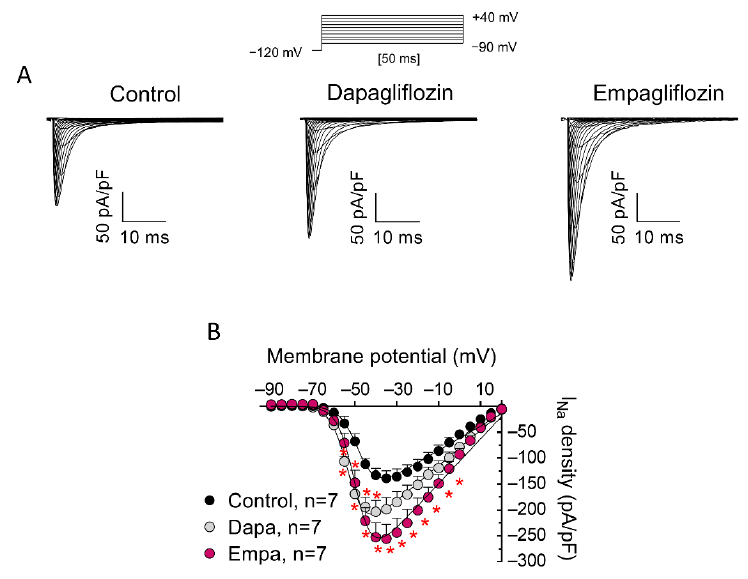
Figure 1. Incubation with dapa and empa increased I Na recorded in hiPSC-CMs. ( A ) I Na traces recorded, using the protocol shown at the top, in three different hiPSC-CMs: incubated with dapa or empa (1 µ M, 24-h) or not incubated (control). ( B ) Current density-voltage relationships for peak I Na recorded in hiPSC-CMs incubated with dapa or empa or not incubated. In B, each point is the mean ± SEM of the “n” experiments indicated in the figure. * p < 0.05 vs. control.